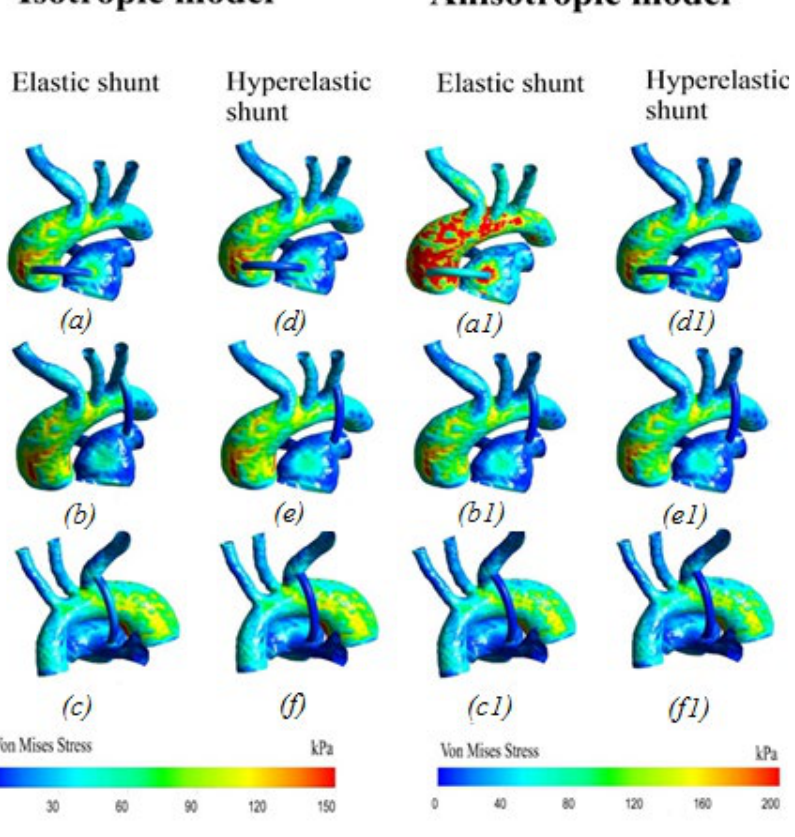
Figure 14. Von Mises stress distribution: ( a , d , a1 , d1 ) central shunt; ( b , e , b1 , e1 ) right shunt; ( c , f , c1 , f1 ) left shunt.